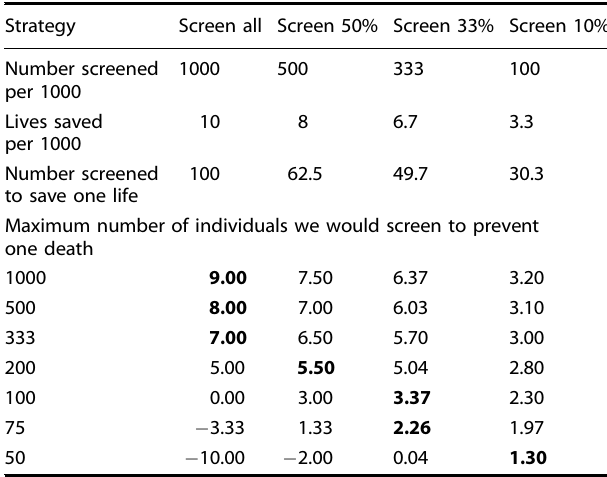
Table 1. Net bene fi t of risk-strati fi ed screening for the hypothetical reference